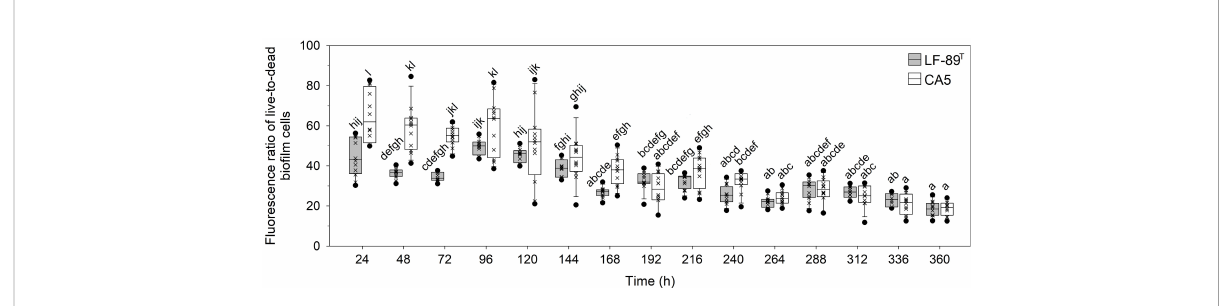
FIGURE 4 Temporal variations in fl uorescence ratio of live-to-dead bacteria in bio fi lms formed by P . salmonis LF-89 T and CA5. Box plots show the medians of data sets (×), upper/lower quartiles (boxes), value ranges (vertical lines), and extreme values (circles). Statistically signi fi cant differences between boxes (Tukey HSD test; P < 0.05) are depicted with different letters. Data were obtained from three independent